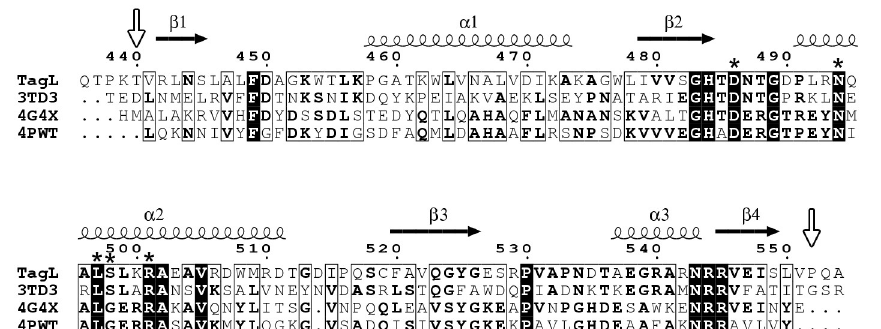
Fig 1. Sequence alignment of the TagL peptidoglycan binding domain (PGBD) with other representative OmpA family proteins. Secondary structure elements and numeration from the TagL PGBD structure are displayed above the alignment. Strictly conserved residues are in black blocks; the five residues that were shown to be required for TagL binding to the cell wall are indicated by an asterisk; selected N and C termini of the TagL PGBD are indicated by vertical arrows. 3TD3: OmpA from Acinetobacter baumannii ; 4G4X: Pal from Acinetobacter baumannii ; 4PWT: Pal from Yersinia pestis . Amino acid sequences were aligned using Multalin [43], and the figure was prepared using ESPript (version 3.0, http://espript.ibcp.fr/)